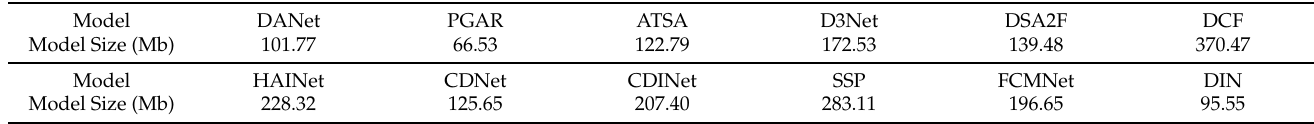
Table 2. Model size of the evaluated